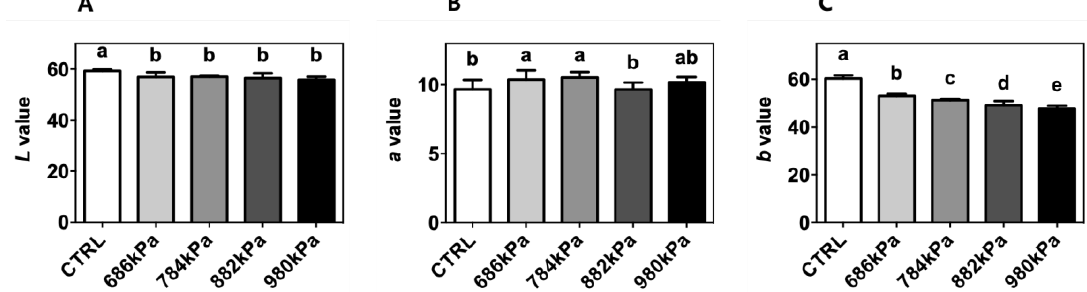
Figure 2. Colorimetric changes in the L ( A ), a ( B ), and b values ( C ) of turmeric following puffing at various pressures ( n = 3). CTRL—control.